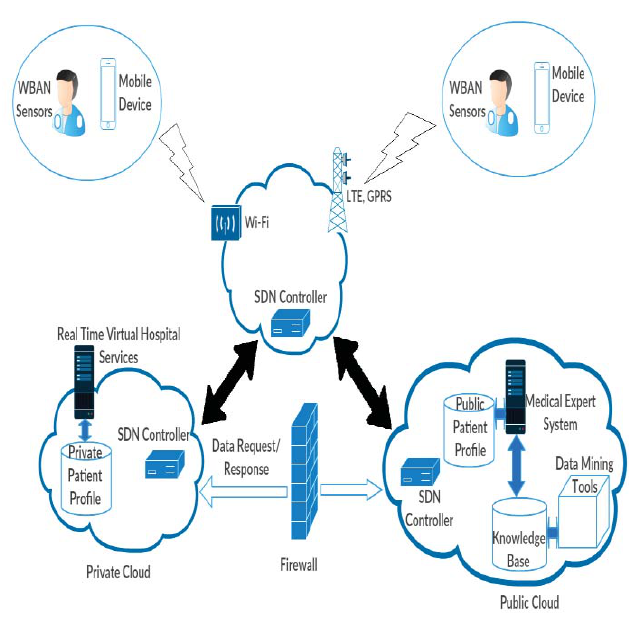
Figure 2: Framework for SDN enabled Cloud based Virtual Hospital